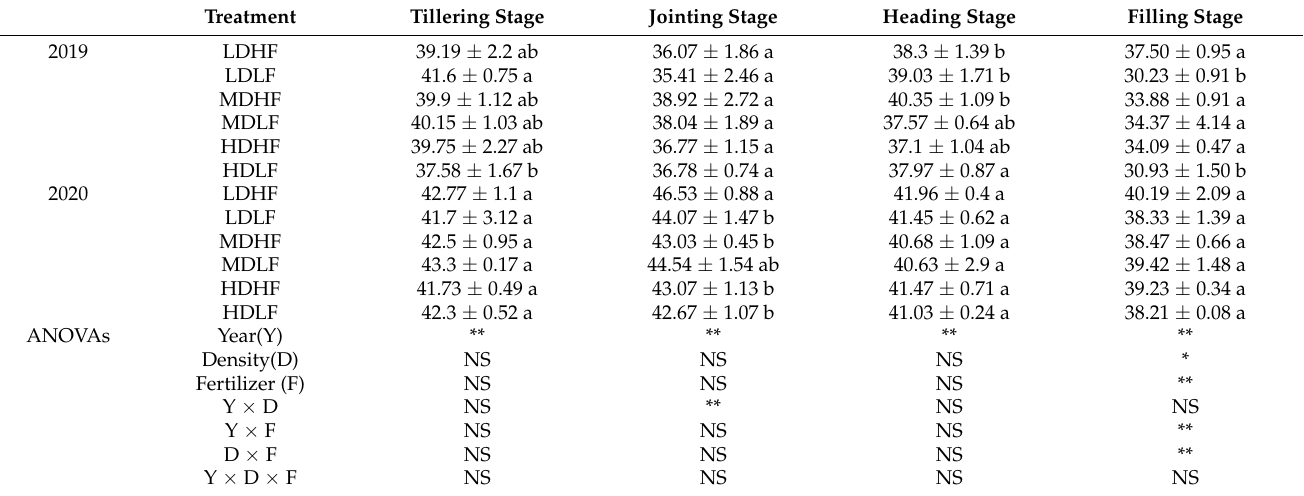
Table 3. SPAD values at different growth stages of rice under different treatments in 2019 and 2020. Treatment Tillering Stage Jointing Stage Heading